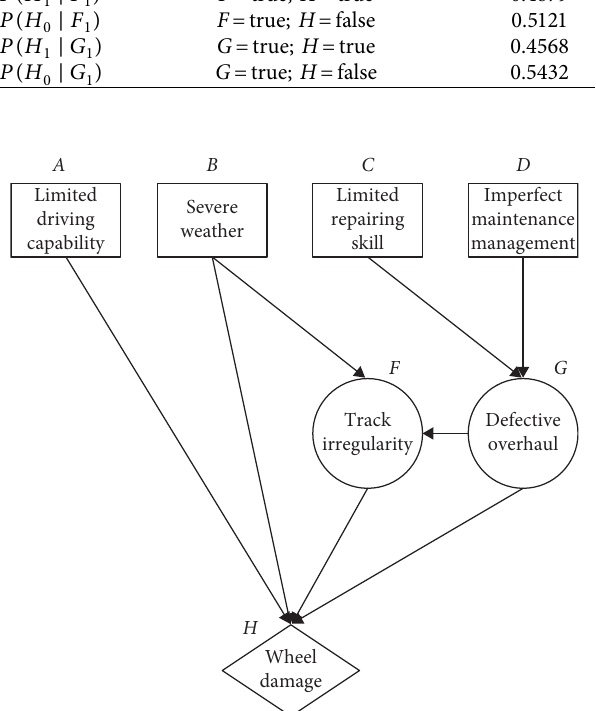
Figure 6: The first step influence diagram.